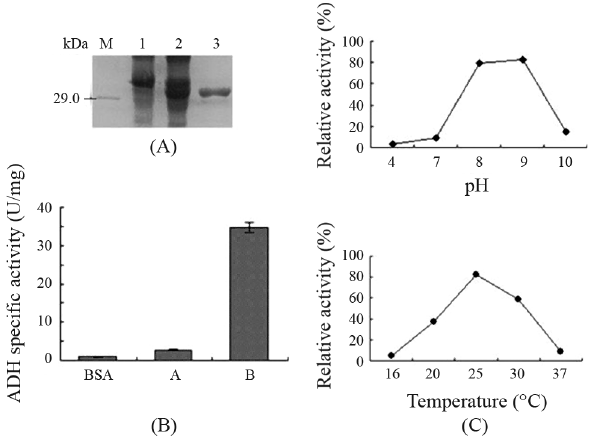
Figure 3 - Electrophoretic and enzymatic characterization and stability of BmADH.(A)SDS-PAGEstainedwithCommassieblue.Mmarker:lane1 - lysate of host cells transformed with empty vector; lane 2 - lysate of host cells with BmADH expressionlane 3 - recombinant BmADH purified by Ni-NTA resin column. (B) Alcohol dehydrogenase specific activity, with BSA (bovine serum albumin) as negative control. A: cell lyaste of BL21 (DE3) with BmADH expression. B: purified BmADH protein. Data repre- sentmean (cid:4) S.D.*indicatesp<0.01comparedtoBSA.(C)Stabilityofal- cohol dehydrogenase activity at different pHs and temperatures. Each point represents the average of duplicate